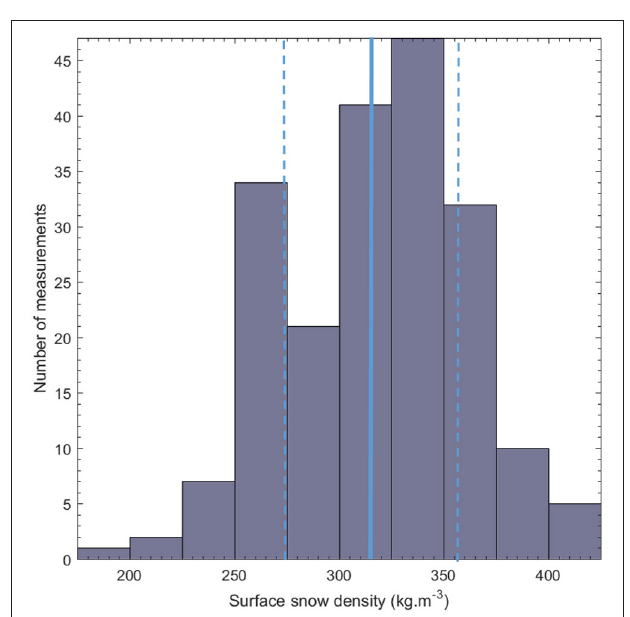
FIGURE 3 | Number of surface snow density measurements over the Greenland ice sheet. Blue solid and dashed lines indicate the average and standard deviation of the dataset,